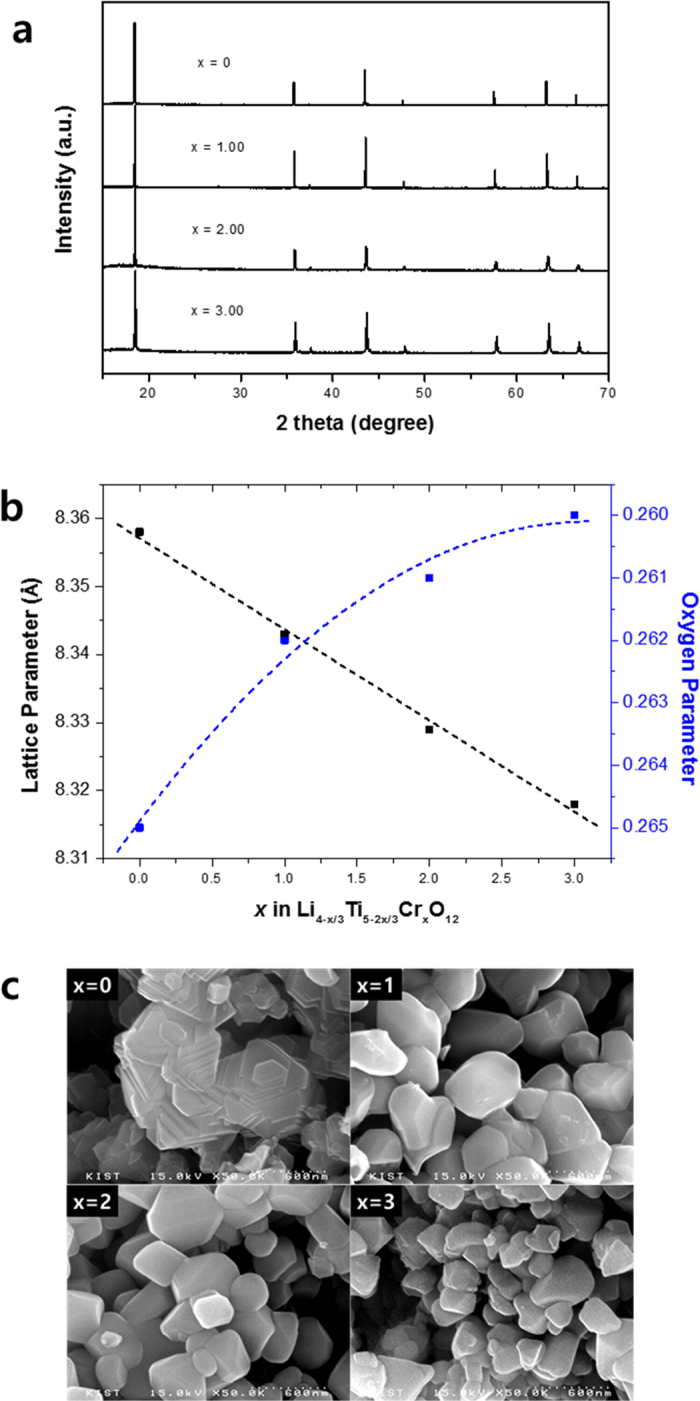
(a) XRD patterns (b) lattice parameters and oxygen parameters, and (c) SEM images of Li4−x/3Ti5−2x/3CrxO12 (x = 0, 1, 2, 3).